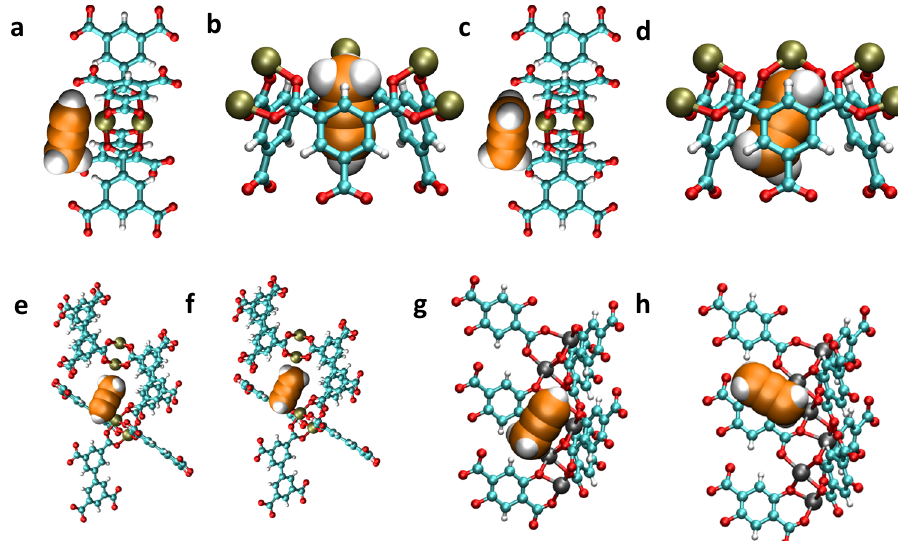
Fig. 7 Perspective views of a portion of the crystal structure of HKUST-1, MOF-505, and Mg-MOF-74, showing the optimized position of propyne and propadiene molecules. a OMSs units of HKUST-1 for propyne. b Tetrahedral cages units of HKUST-1 for propyne. c OMSs units of HKUST-1 for propadiene. d Tetrahedral cages units of HKUST-1 for propadiene. e OMSs units of MOF-505 for propyne. f OMSs units of MOF-505 for propadiene. g OMSs units of Mg-MOF-74 for propyne. h OMSs units of Mg-MOF-74 for propadiene. Atom colors: C(MOF) = cyan, C(propene) = orange, H = white, N = blue, O = red, Cu = oliver green, Mg =